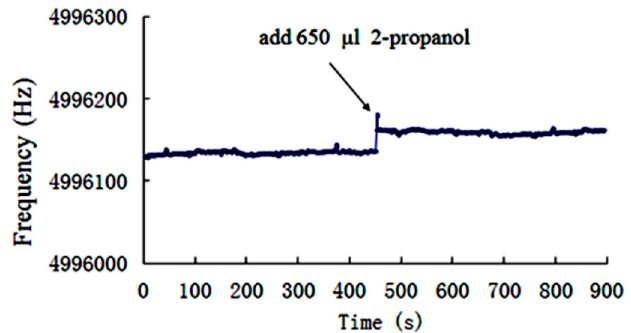
Figure 8. Frequency time responses of the quartz LFE device in aqueous solutions of 2-Propanol with a minor concentration variation (the initial concentration is 60 % ).